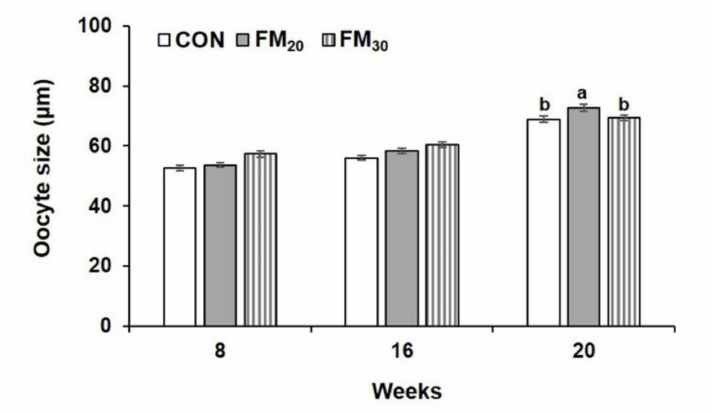
Figure 4. Oocyte diameters measured at 100 × magnification at 8 weeks, 16 weeks, and 20 weeks. Data are presented as the mean ± SEM ( n = 10). Different letters above the bars indicate significant differences ( p < 0.05) between groups. CON, control diet; FM 20 , diet with 20% of the fishmeal replaced; FM 30 , diet with 30% of the fishmeal